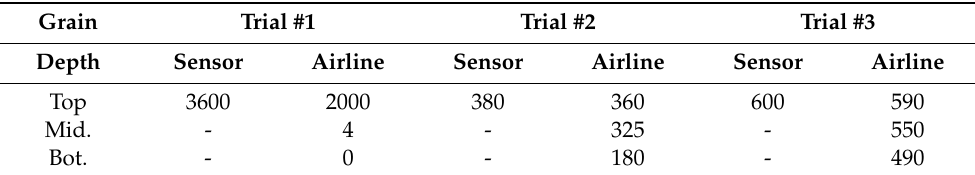
Table 1. Phosphine concentrations (ppm) measured with the wireless sensor at the top and